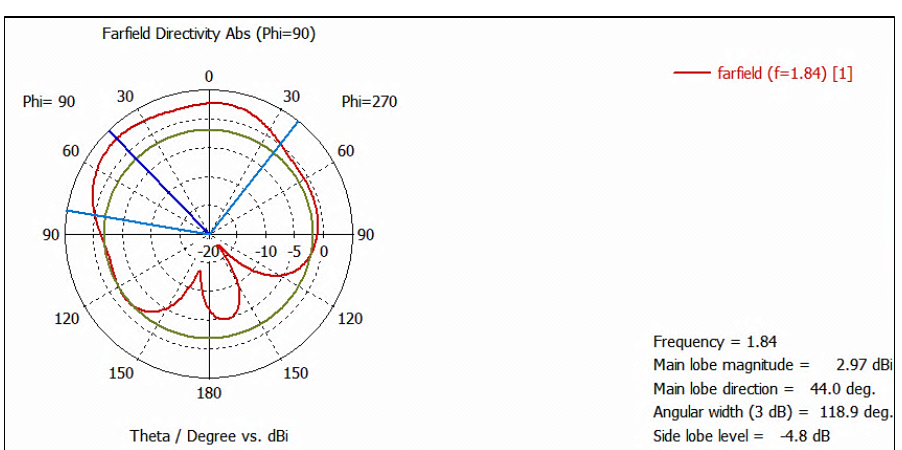
Figure 14. Antenna pattern at second frequency ( 𝑻𝒉𝒆𝒕𝒂 = 𝟗𝟎 )